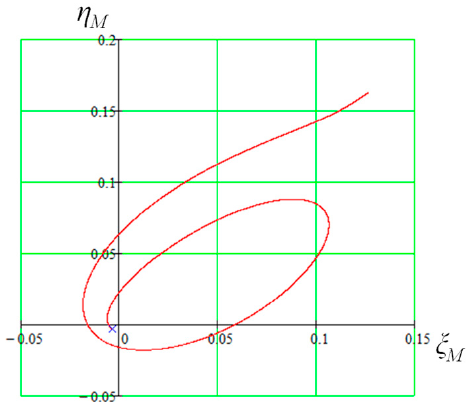
Figure 29. Relative selenocentric distance r M [undim] of the SC during its trajectory motion in the “near-moon” section up to a circular orbit of a given radius.